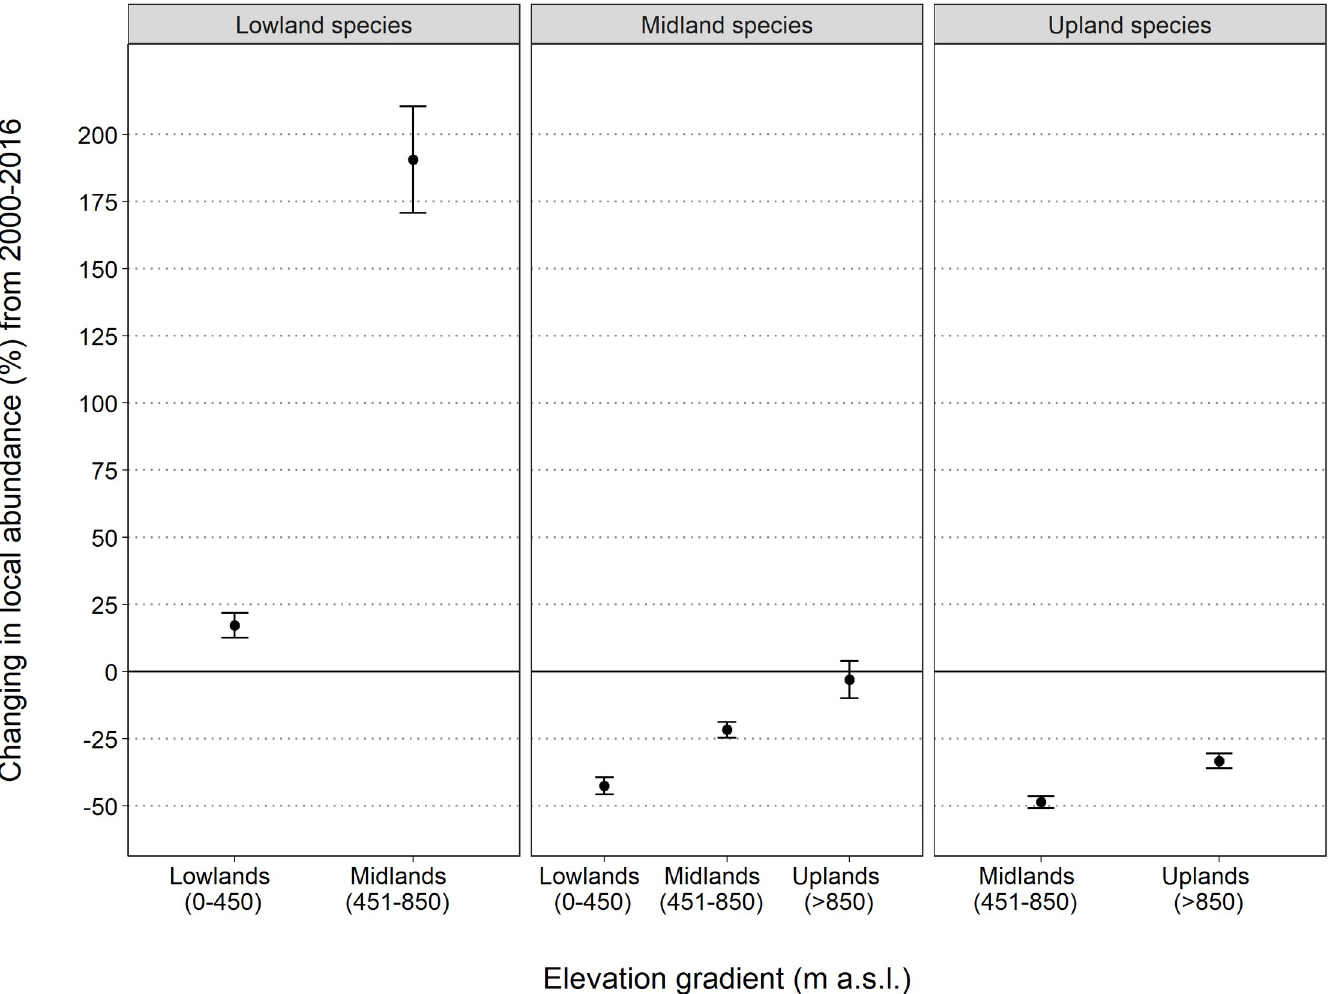
Fig 3. Elevational shifts in local abundance patterns in bird assemblages between 2000 to 2016. Baseline population set to 0 with values above the baseline representing an increase in local population abundance and values below the baseline representing a decline. Values represent the change in local abundance over the full time period based on the mean multiplicative slope of the multi-species trend with its SE (error bars). See the full abundance trends over time for each combination of elevational band and species group in supplementary material.